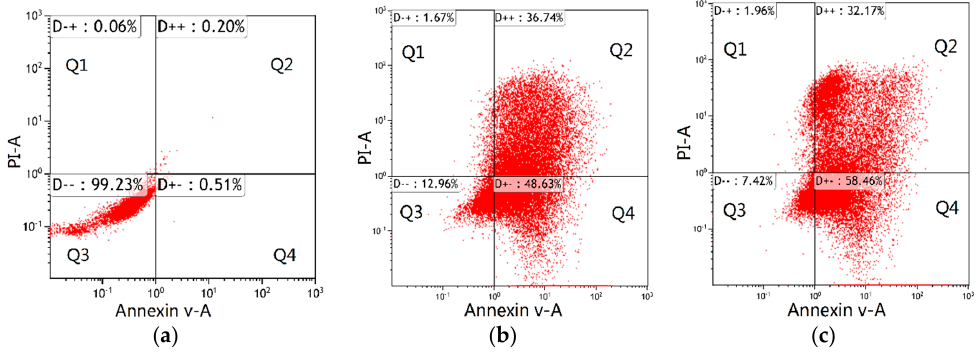
Figure 4. Apoptosis ratio detection of compound 4u by Annexin V-FITC (Fluorescein Isothiocyanate)/PI (Propidium Iodide) assay. ( a ) HeLa cells were not treated with 4u for 12 h; ( b , c ) HeLa cells were treated